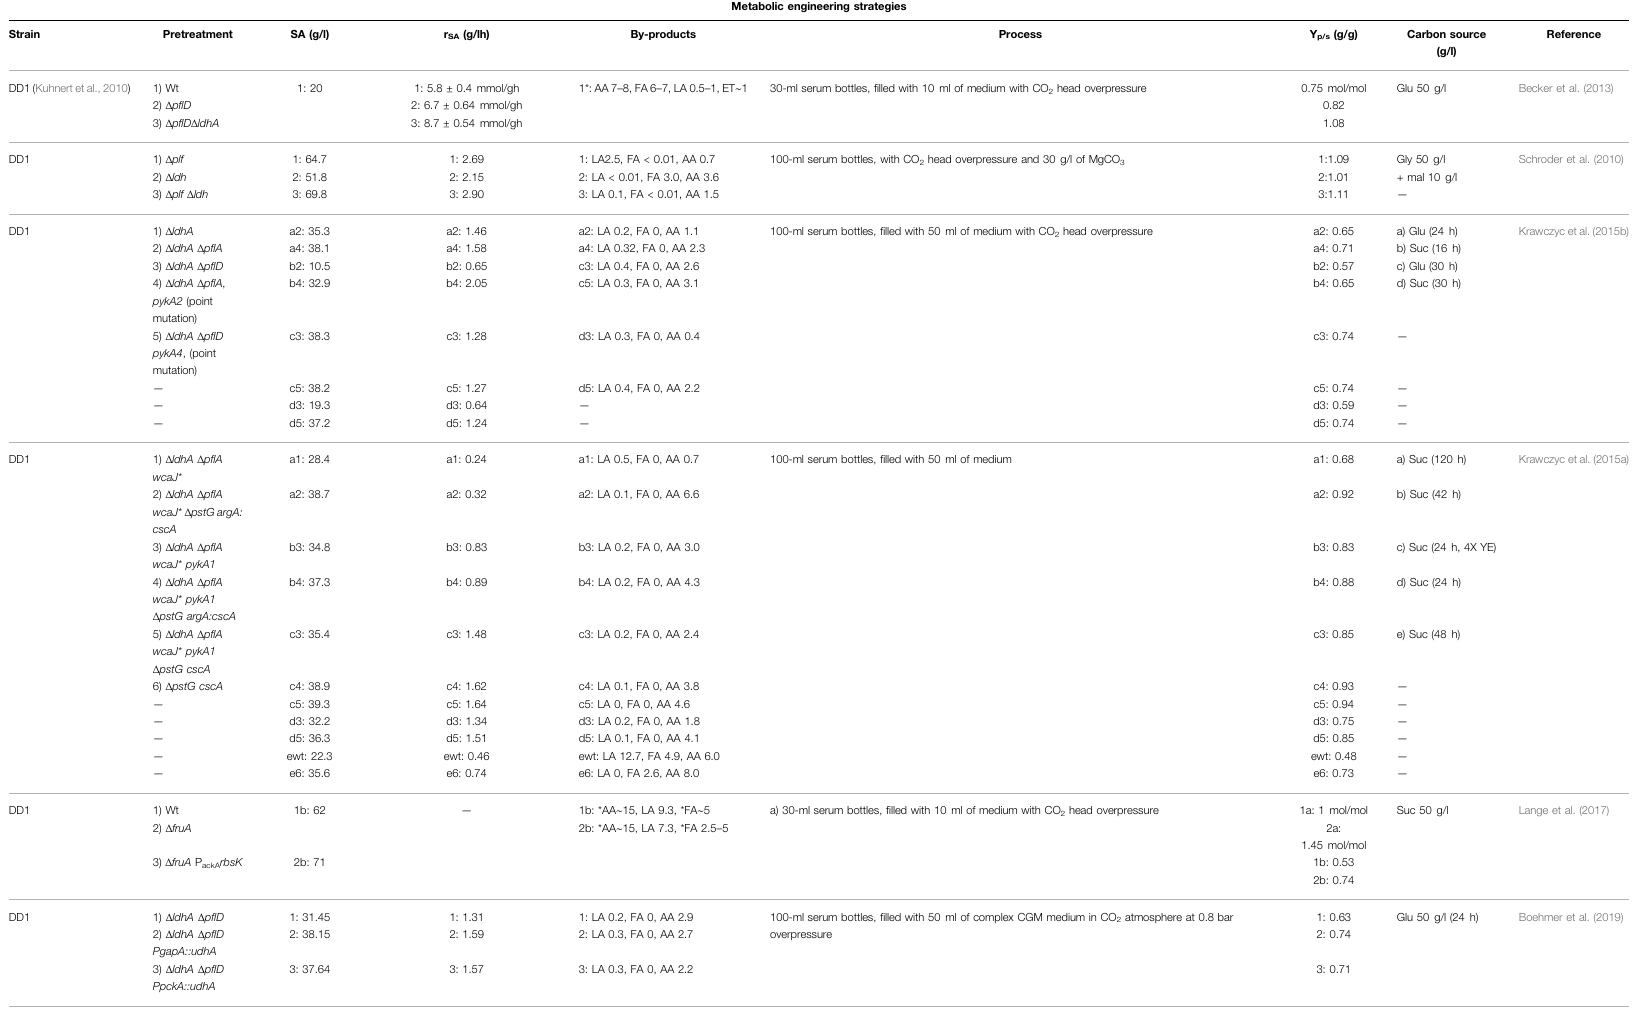
TABLE 1 | Engineering and fermentation strategies used to improve succinic acid production in B. succiniciproducens and fermentation processes developed for the production of succinic acid from wild-type B. succiniciproducens spp. on renewable materials. N.R., not reported. TA, total acid by-products; Glu, glucose; Gly, glycerol; Suc, sucrose; Mal, maltose; DDAPH, deacetylated dilute acid-pretreated hydrolysate; Xyl, xylose; Fru, fructose; TS, total sugars; SSL, spent sul fi te liquor; LS, lignosulfonates. *indicates values deduced from graphs reported in the relative publication or calculated from the yields. Batch: closed process in which all nutrients are added at time zero and all products remain in the bioreactor until the end of the run; Fed-batch, semi-open process, in which after a batch phase nutrients are fed to prolong the growth phase, and all products remain in the bioreactor until the end of the run; Chemostat, open process in which nutrients are continuously added to the reactor and products (and unconsumed nutrients) are removed at the same rate to keep the volume constant. Metabolic engineering strategies Reference Strain Pretreatment r SA (g/lh) By-products Process Y p/s (g/g) Carbonsource (g/l) DD1(Kuhnertetal.,2010)